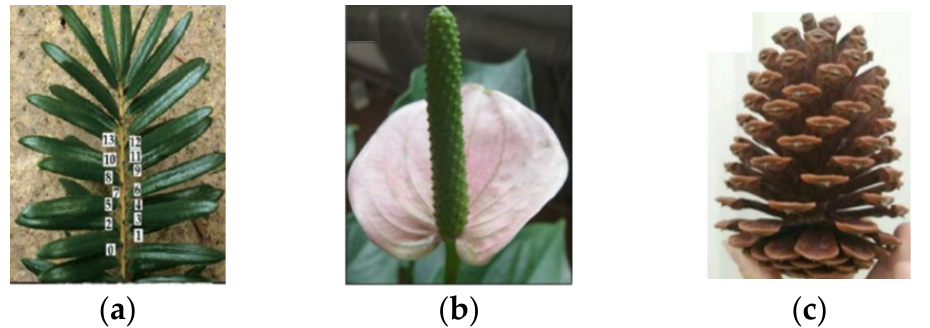
Figure 8. Typical examples of phyllotactic patterns: ( a ) keteleeria davidiana, ( b ) anthurium, and ( c ) pinecone [62].